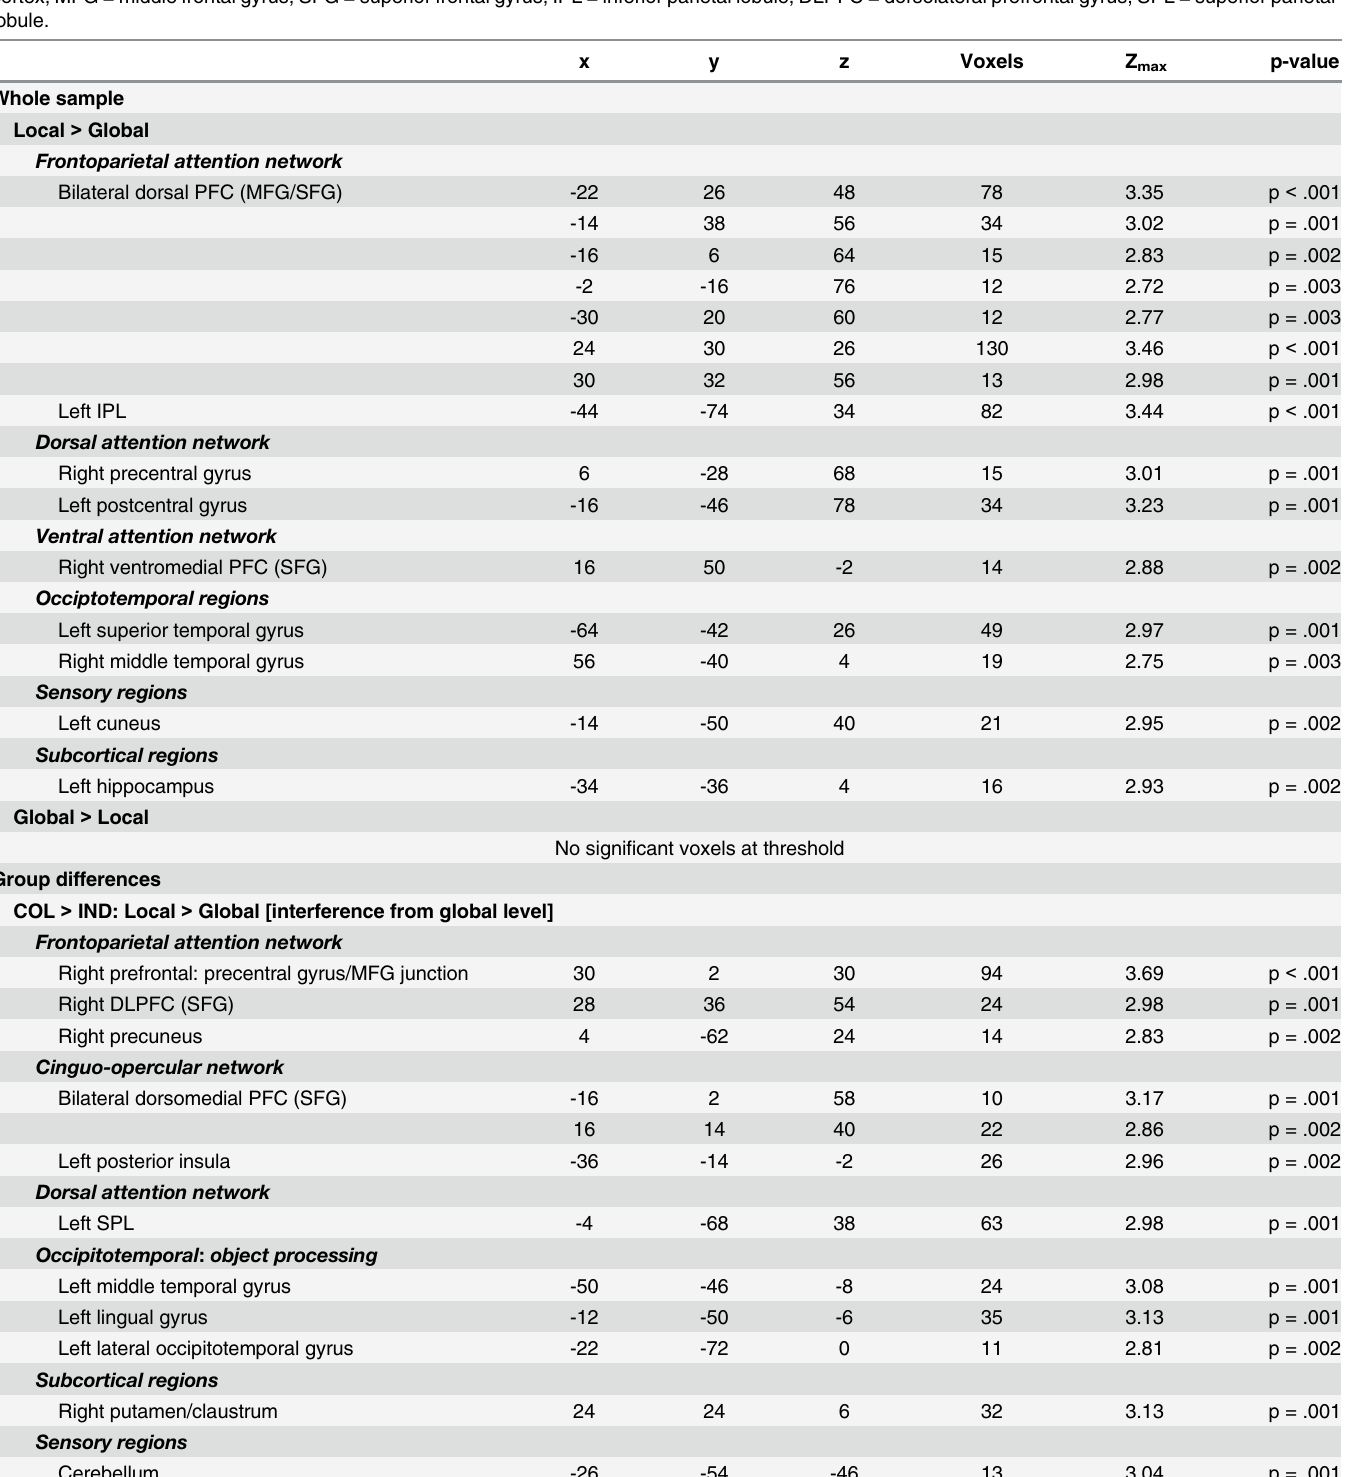
Table 4. Global vs Local condition comparisons for whole sample and between group analyses (IND = Individualist group; COL: Collectivist group). Coordinates are provided in MNI (Montreal Neurological Institute) space; Threshold p < .005, minimum cluster threshold 10 voxels. PFC =